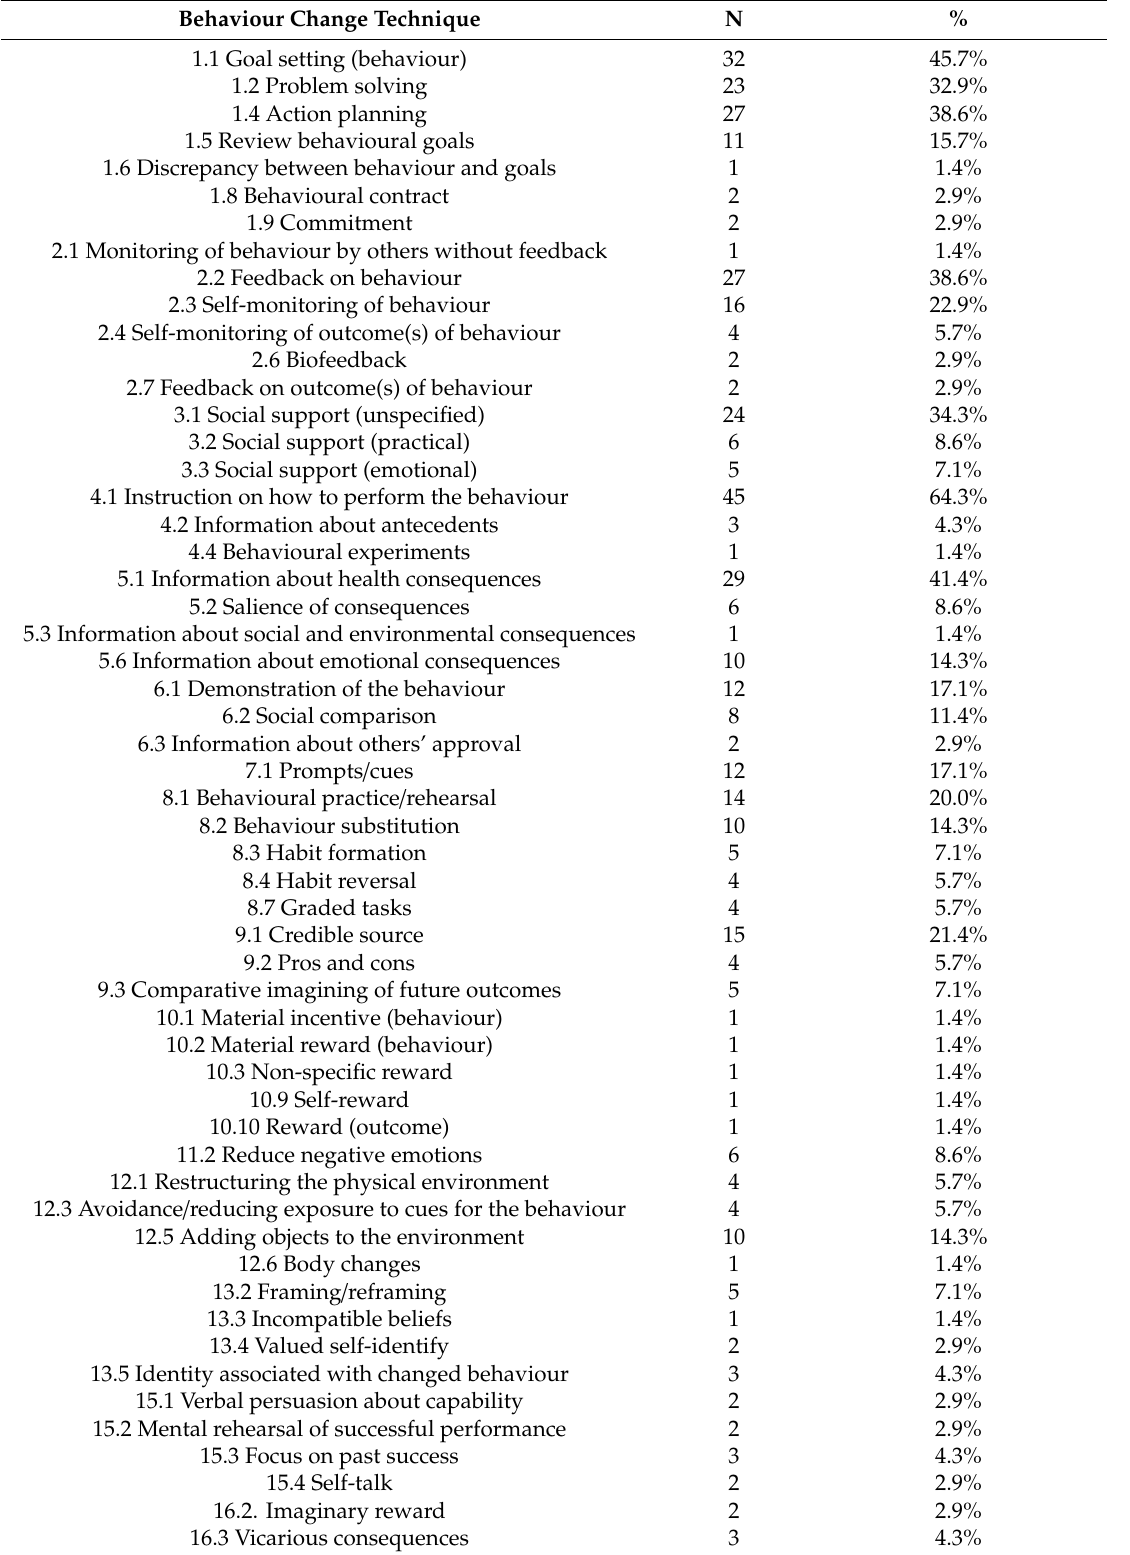
Table 2. Behaviour change techniques used a